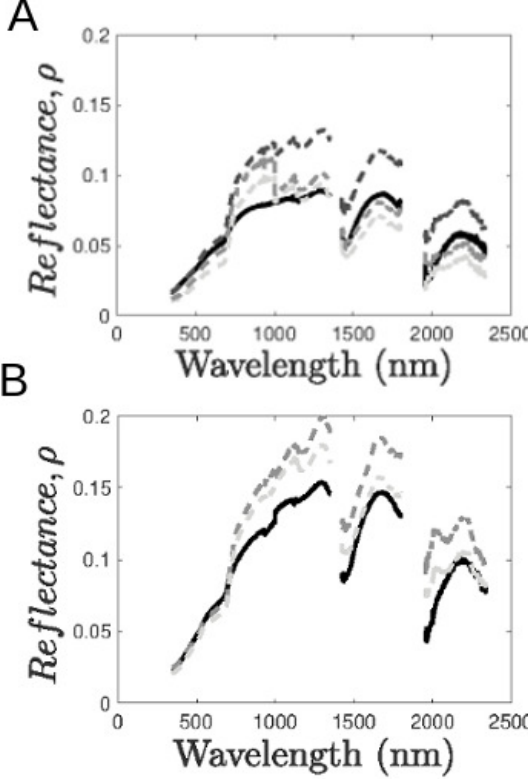
Figure 2. S. densiflorus signatures recorded with a field radiometer. Variability in the reflectances of this vegetation is shown in two examples (A-B) In each figure reflectance measurements taken after each successive harvest are plotted in dotted lines, as explained in Sec.2.2. The bare soil is plotted in solid black